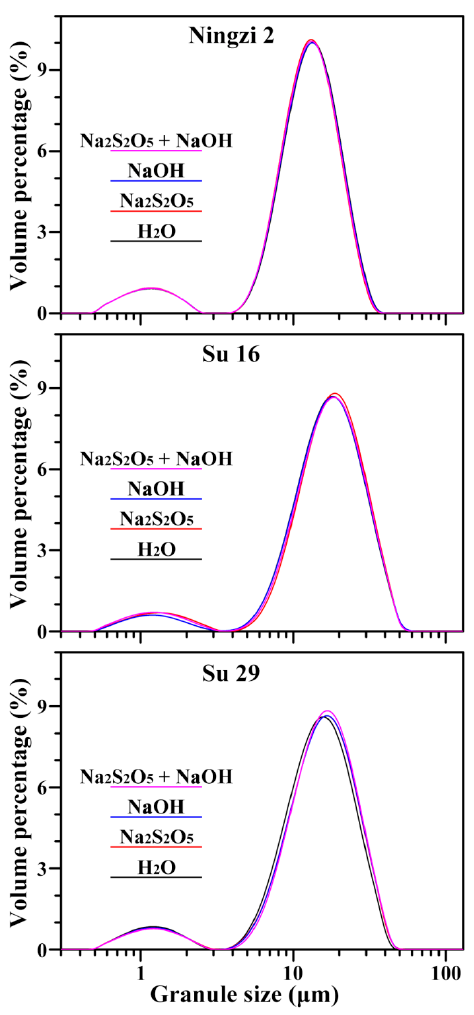
Figure 2. Size distribution of starch granules.